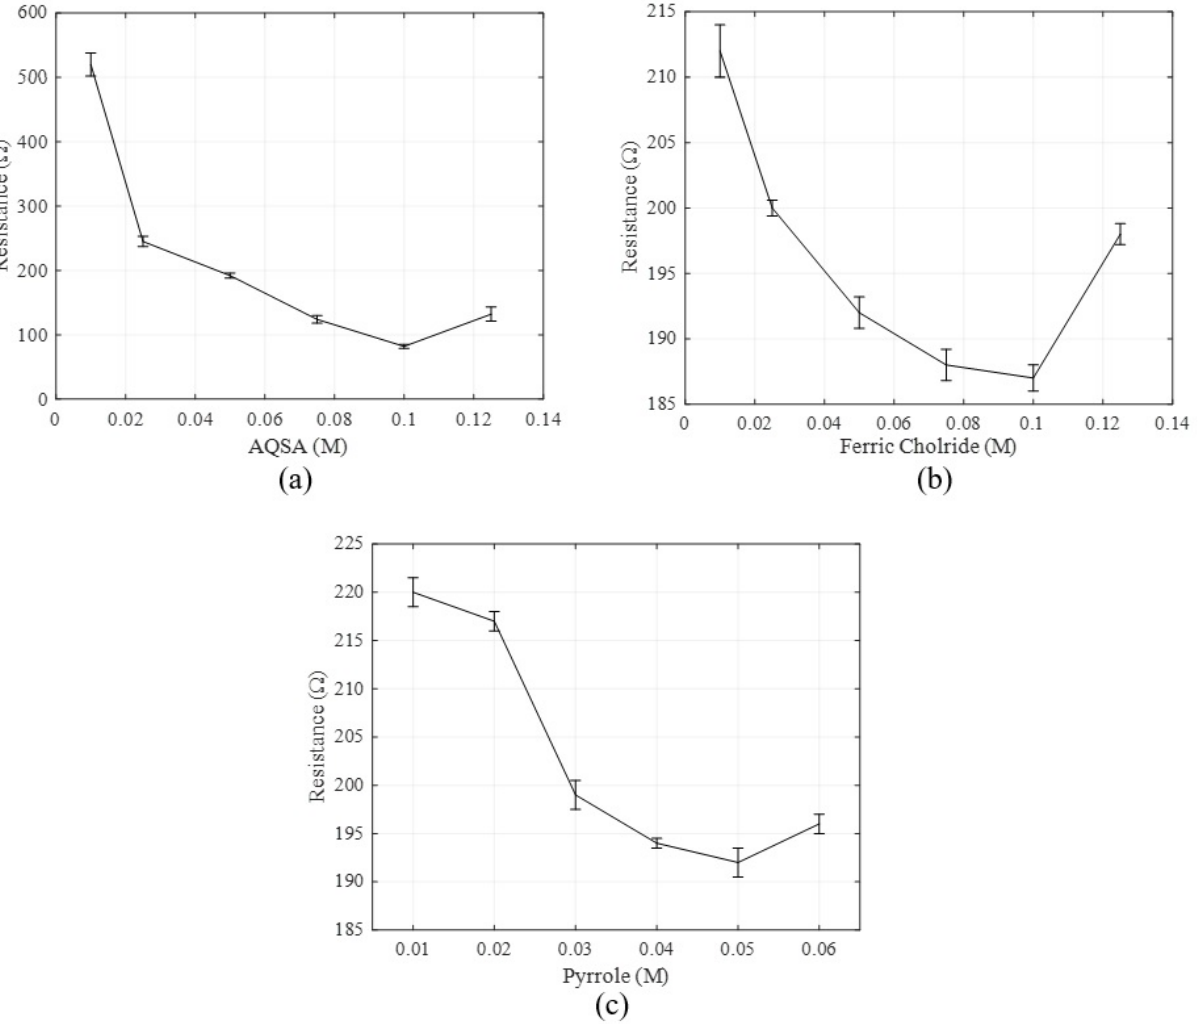
Figure 5. ( a ) Average resistance of fabric samples versus concentration of the dopant AQSA, ( b ) Average resistance versus the oxidant ferric/iron(III) chloride concentration, and ( c ) Average resistance versus the monomer pyrrole